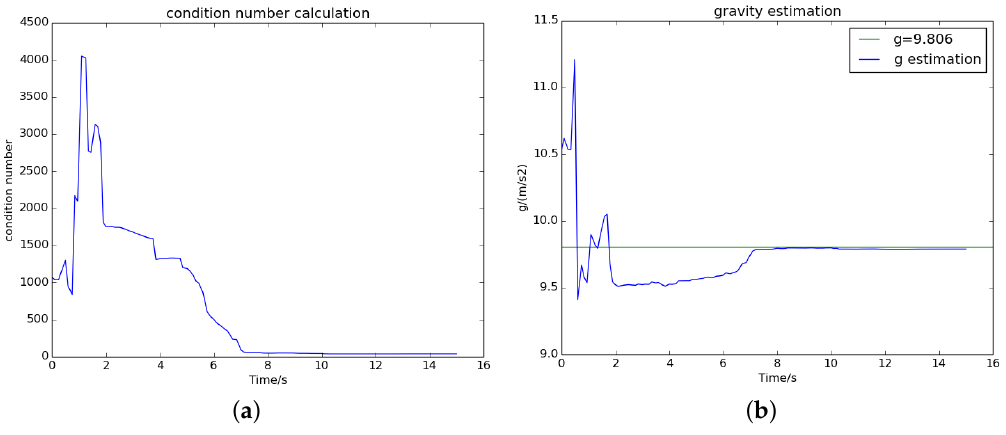
Figure 6. The convergence process of ( a ) the condition number and ( b ) the estimated gravity on sequence V2_02_medium.